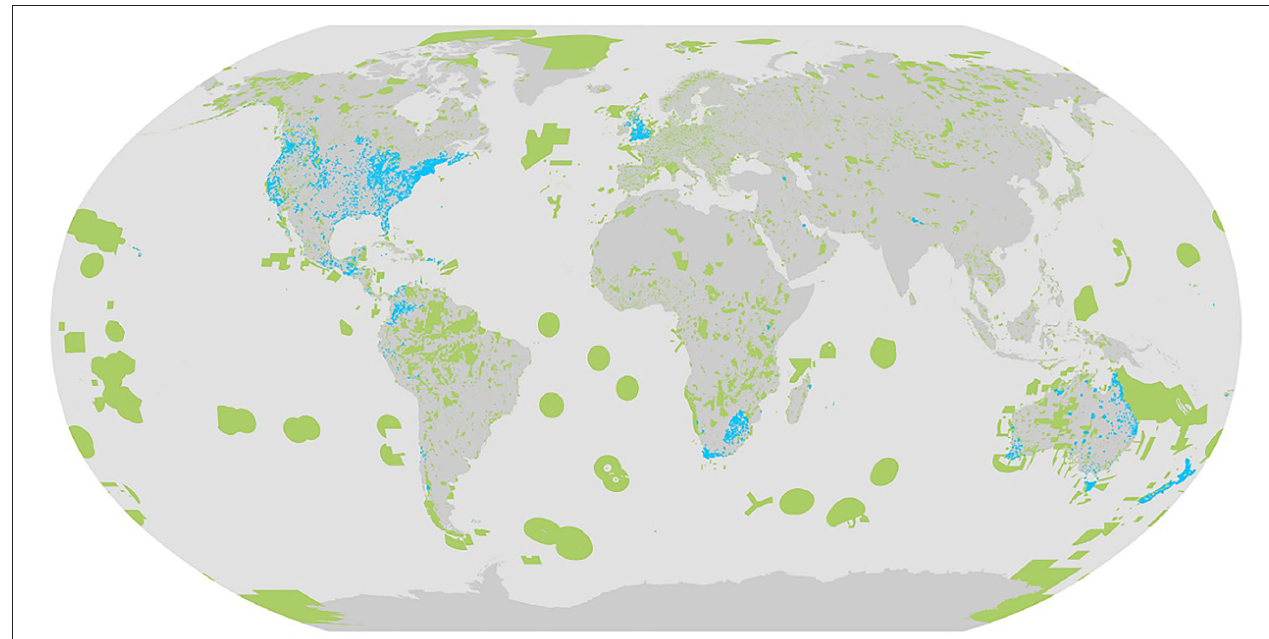
FIGURE 1 | Privately Protected Areas (PPAs) (blue; outlines included for visibility) in the World Database on Protected Areas, June 2021 (UNEP-WCMC and IUCN, 2021a ), based on records with the governance types “Individual landowners,” “For-profit organisations,” and “Non-profit organisations,” plus the New Zealand PPAs, which do not have a reported governance type. Some PPAs may be incorrectly classified as another governance type in the WDPA and thus not shown on the map. Other protected areas are shown in